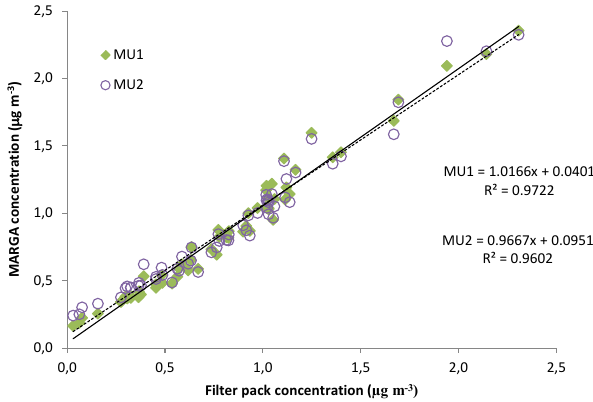
Figure 19. Regression analysis of MARGA NH + Fig. 19. Regression analysis of MARGA NH 4+ concentrations against filter pack NH 4+ 2 against filter pack NH + concentrations. 3